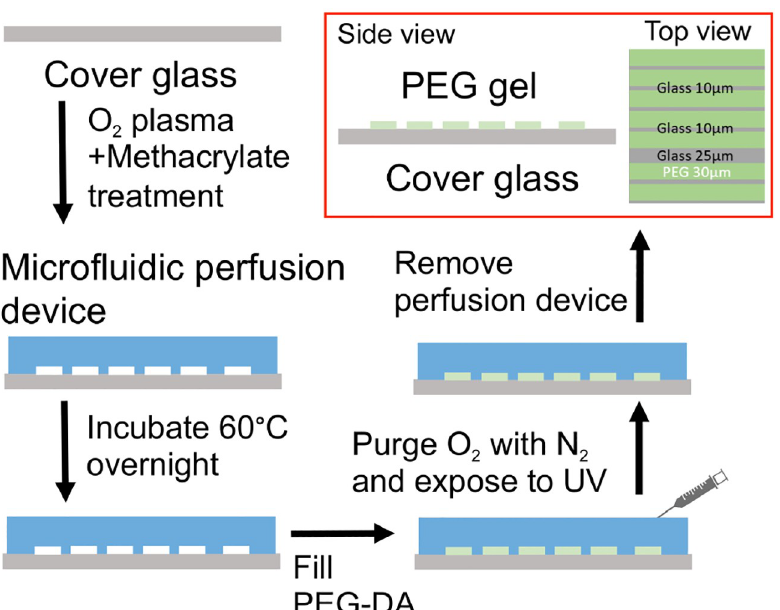
Fig 1. Schematic steps in micropattern substrate fabrication process. A micropattern of alternating PEG-gel and glass stripes is created by attaching a microfluidic chip to a clean microscope coverglass, reversibly bonding the device to the coverglass by overnight incubation at 60˚C, filling microchannels of the devices with PEG-gel pre-polymer, purging O 2 in an N 2 chamber, cross-linking the PEG-gel by a UV-exposure, and detaching the microfluidic chip from the coverglass.